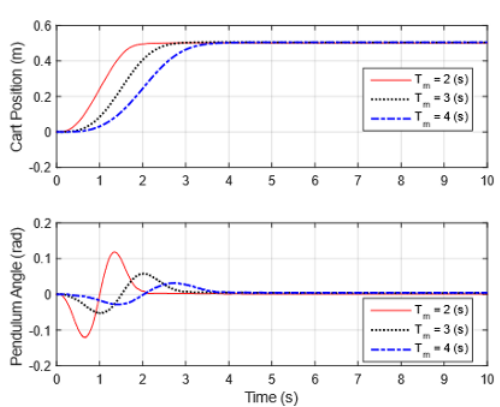
Fig. 4. Trajectory with different terminal time to same target position.